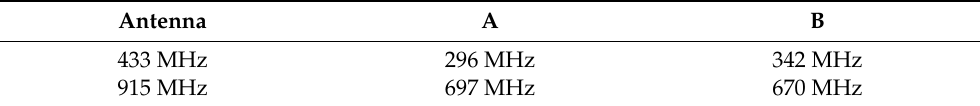
Table 3. Resonance frequencies of antennas when immersed in the bio-phantom.